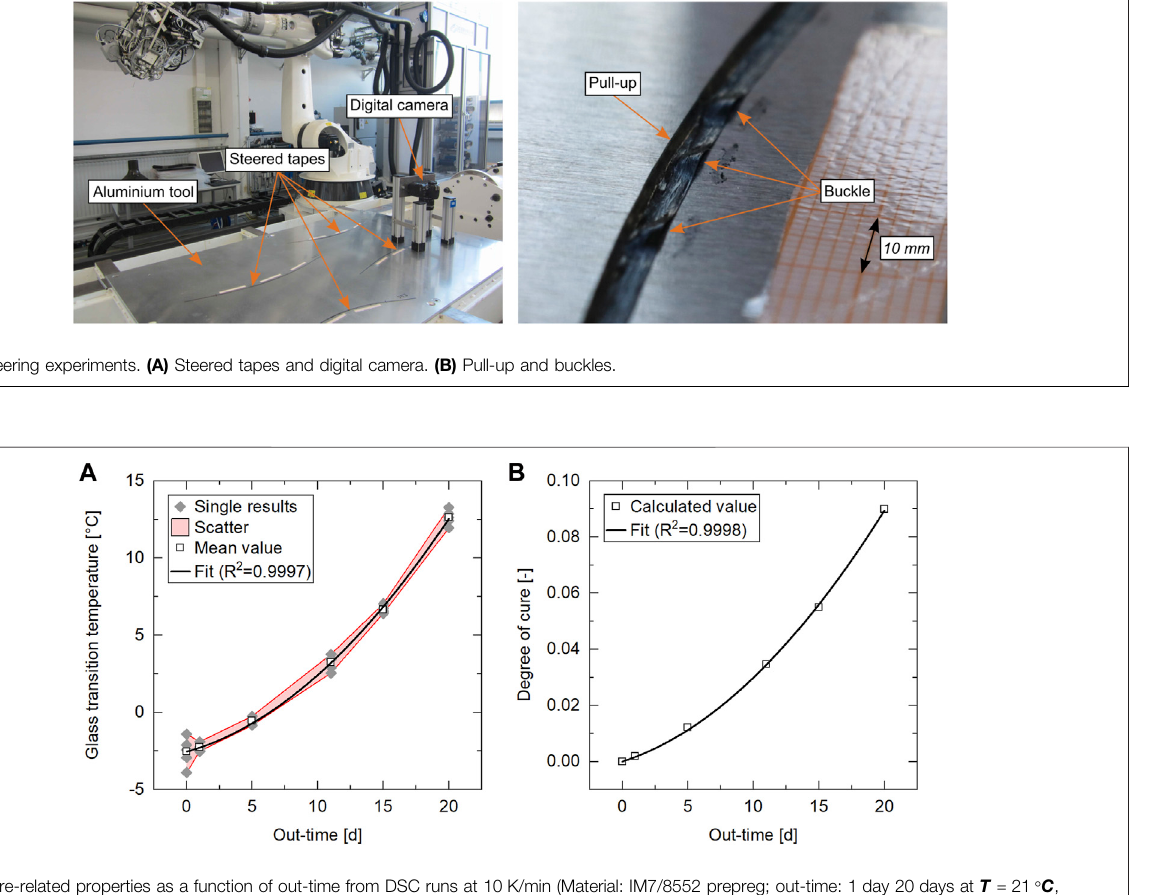
Frontiers in Materials |